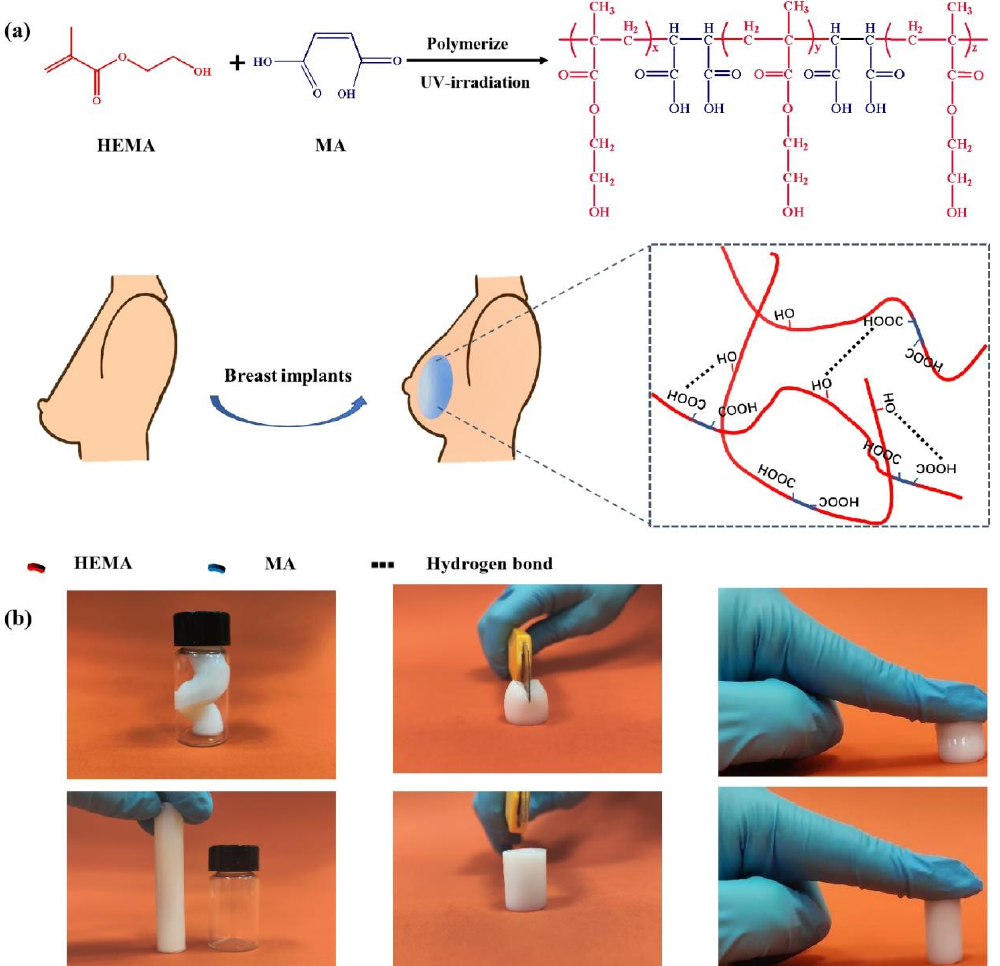
Figure 1. ( a ) Schematic diagram of the fabrication procedure of PHMx hydrogels. ( b ) The hydrogels can withstand a high degree of various mechanical deformations such as bending, cutting, and